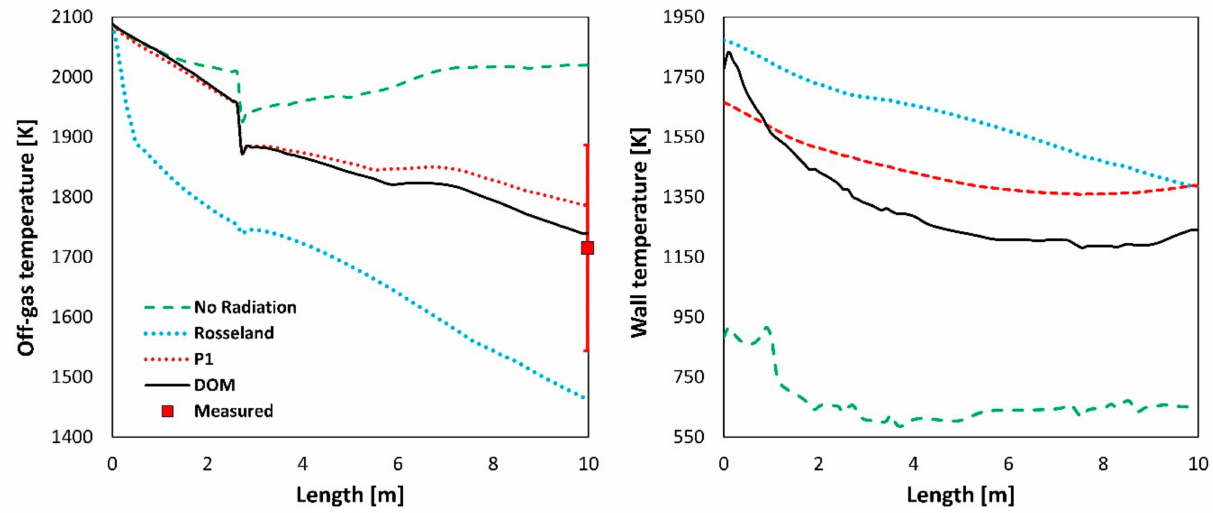
Figure 17. Off-gas and wall temperature profile across the reflux chamber length for different radiation